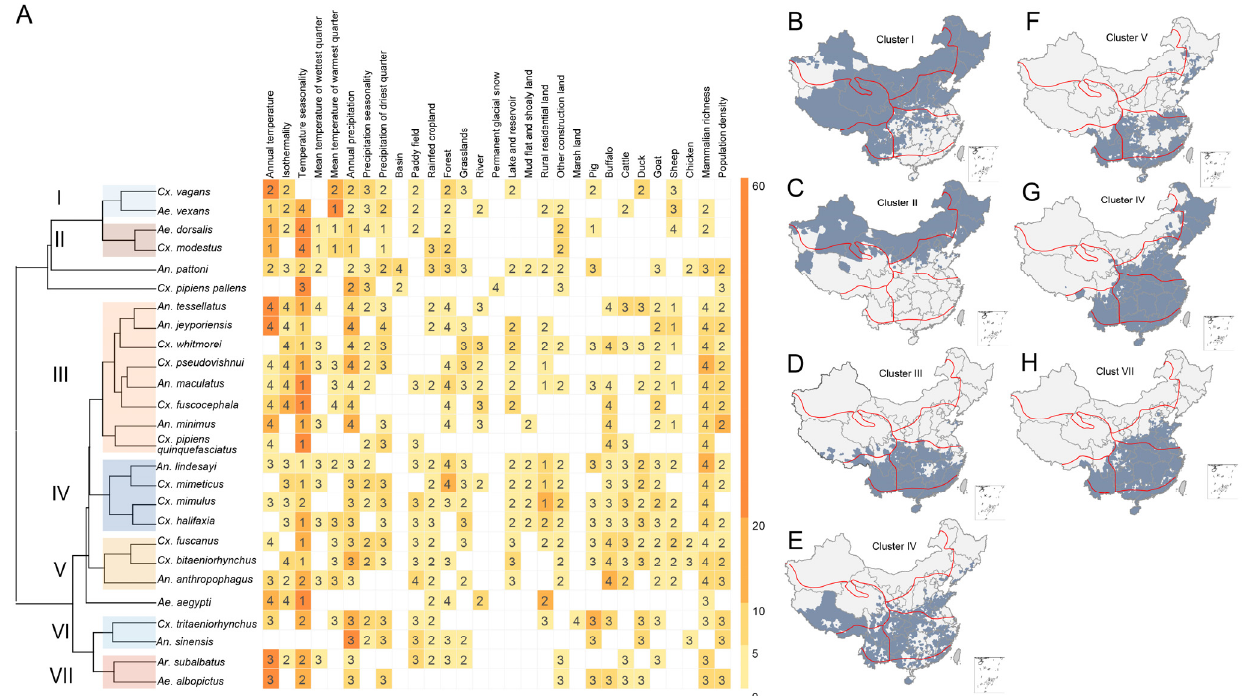
Figure 1. Clustering of mosquito species based on their ecological features and spatial distributions at the county level. Panels ( B )–( H ) indicate the spatial distributions of the seven clusters (clusters I ‒ VII). The boundaries of the seven biogeographic zones are shown as red solid lines. The dendrogram in panel ( A ) displays the clusters I ‒ VII of mosquito species. The features used for clustering are three quantities associated with each predictor in the BRT models. Two of the three quantities were displayed in panel ( A ) to indicate the possible level of ecological suitability: relative contributions (colors in ascending order from yellow to orange) and standardized median value of the predictor (numbers in the heatmap) among counties with mosquito occurrence (numbers 1 ‒ 4 indicate the position of this median in reference to the quartiles of this predictor among all counties).